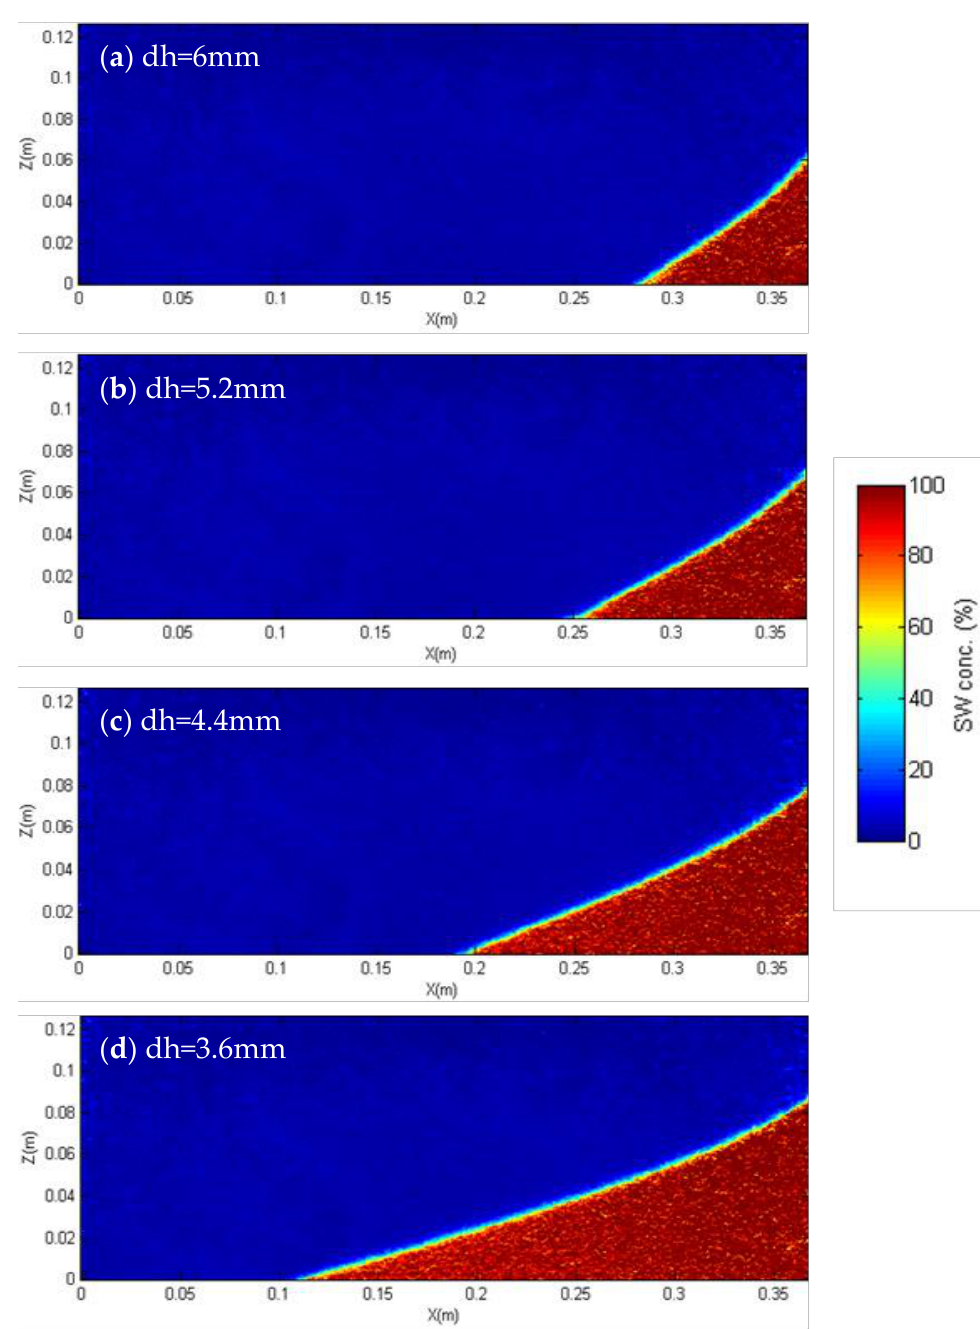
Figure 3. Experimental concentration colour maps of the aquifer system for the various head differences (dh) in case FW 1325: dh = 6mm ( a ) followed by freshwater drop to 5.2 mm ( b ), 4.4 mm ( c ) and 3.6 mm ( d ). Only one case is shown (case 1325) for one scenario (FW) for the sake of brevity. (from Abdoulhalik and Ahmed [13]). Table 2. Experimental toe length results in the FW and SL scenarios for the two bead sizes consid- ered.